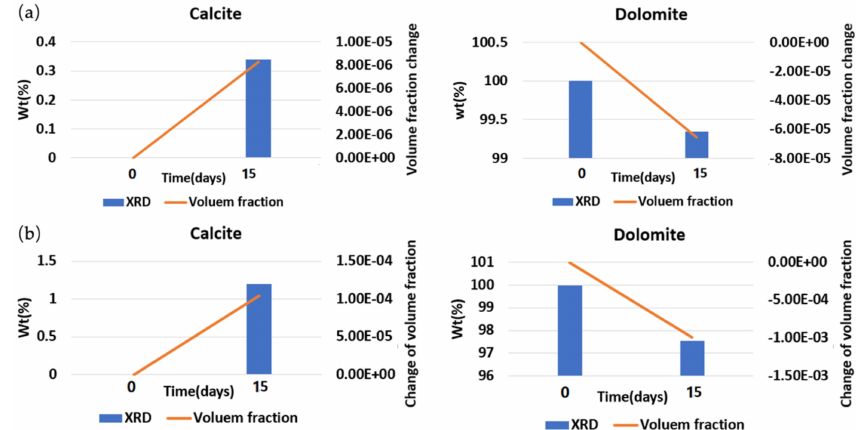
Figure 10. Comparison of XRD results and predicted results: ( a ) Case 6; ( b ) Case 6